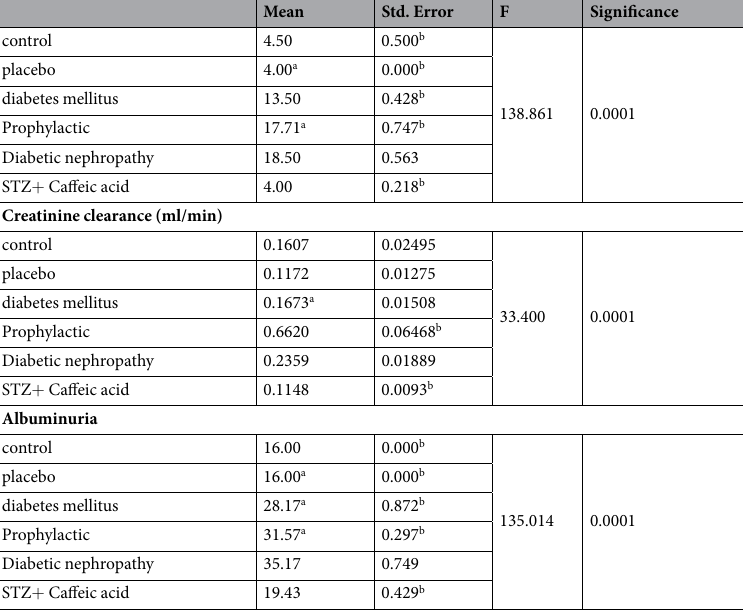
Table 1. Effect of Caffeic acid on urine and serum metabolic and renal markers. a p < 0.05 compared to non diabetic control. b p < 0.05 compared to STZ induced DN control